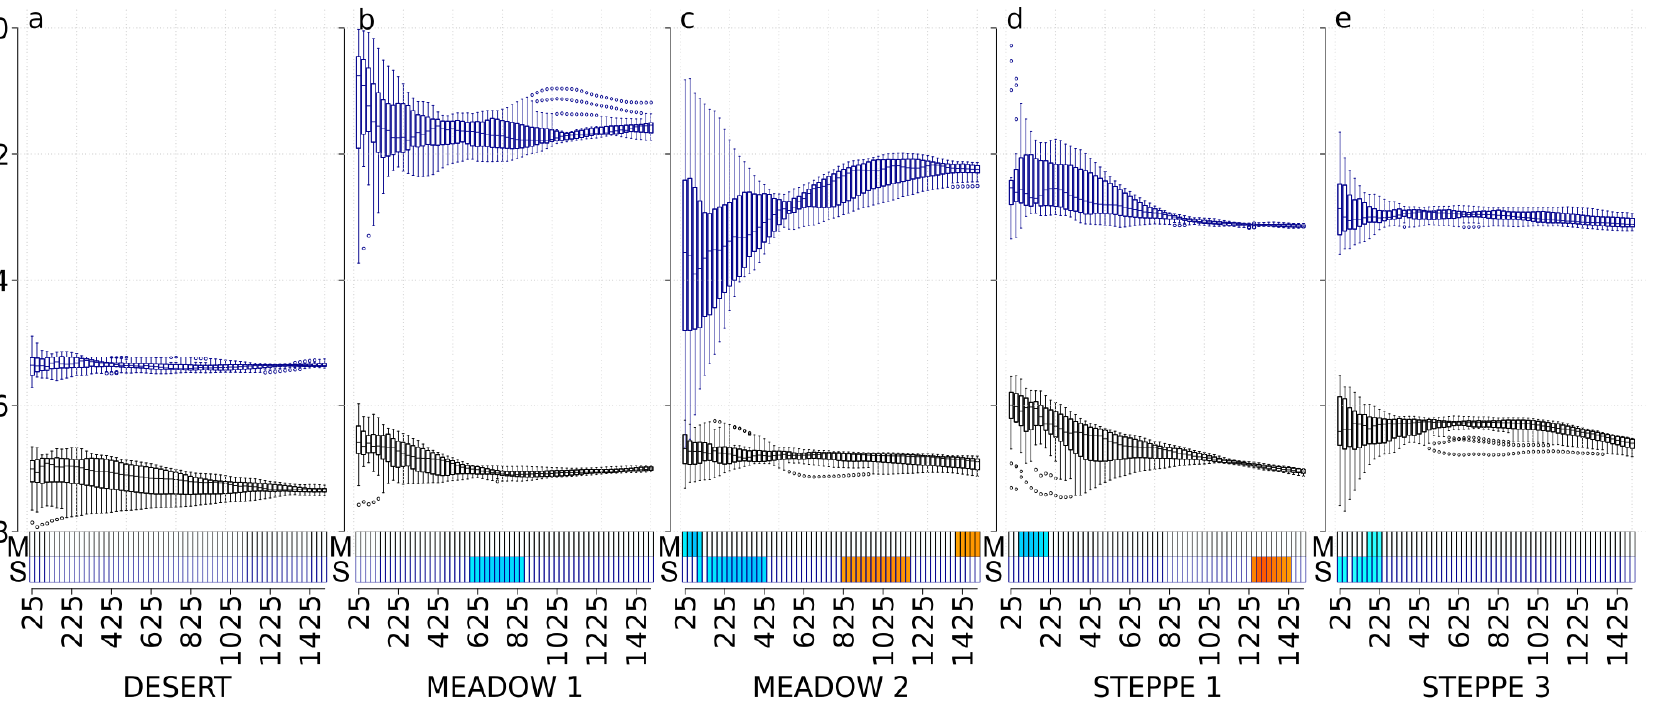
Figure 4. Tasseled-cap wetness values at each scale and correlations with carabid abundances for the desert steppe (a), the meadow steppe 1 and 2 (b and c, respectively), and the typical steppe 1 and 3 (d and e, respectively). Boxplots represent the tasseled-cap wetness values with a black border for the May 2017 Landsat image (M) and with a dark-blue border for the September 2017 Landsat image (S). For each boxplot, a different background color indicates a significant difference in tasseled-cap wetness values using the Tukey test. The x -axis presents the different spatial scales used in the analysis (cardinal distances in meters representing circle radius ranging from 25 to 1500 m). The correlation with carabid abundances is represented with rectangles at the bottom of each graph, using a gradient from blue to red (dark blue corresponds to a negative correlation, dark red corresponds to a positive correlation, and white corresponds to no significant correlation).